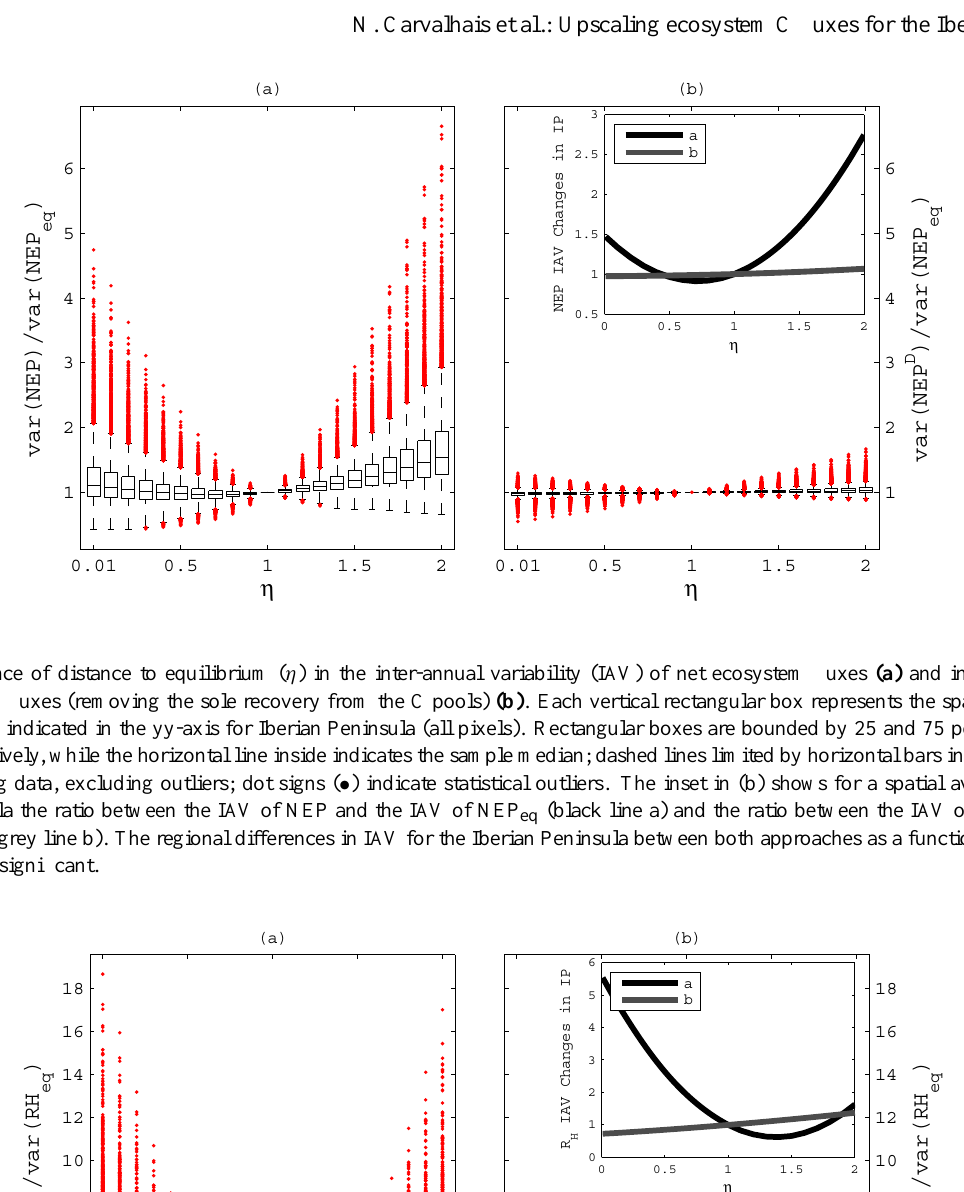
and the IAV of RH eq H